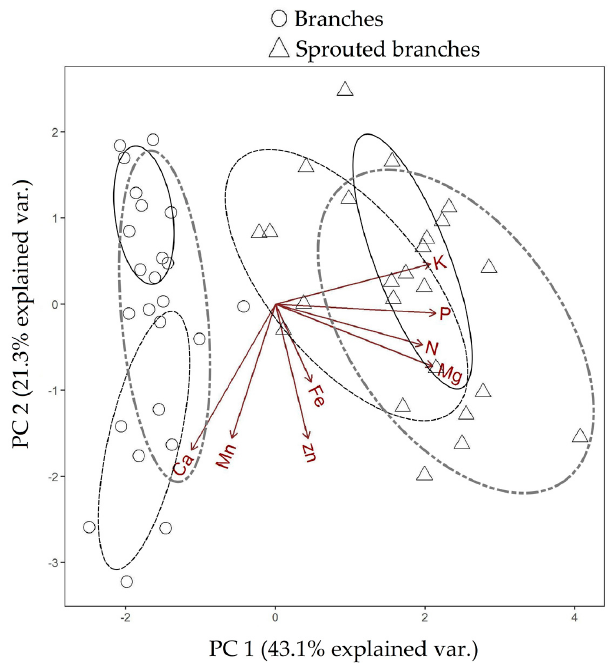
Figure A3. Biplot graph with two first principal components (PC 1 and PC 2) showing the ordering of branch chemical attribute data for “reference” and “regrowth” material collected by sequential management of the Rosewood mass in the three study areas. Ellipses with dash, dash dot dot and solid line, correspond to areas C10, C12 and C17